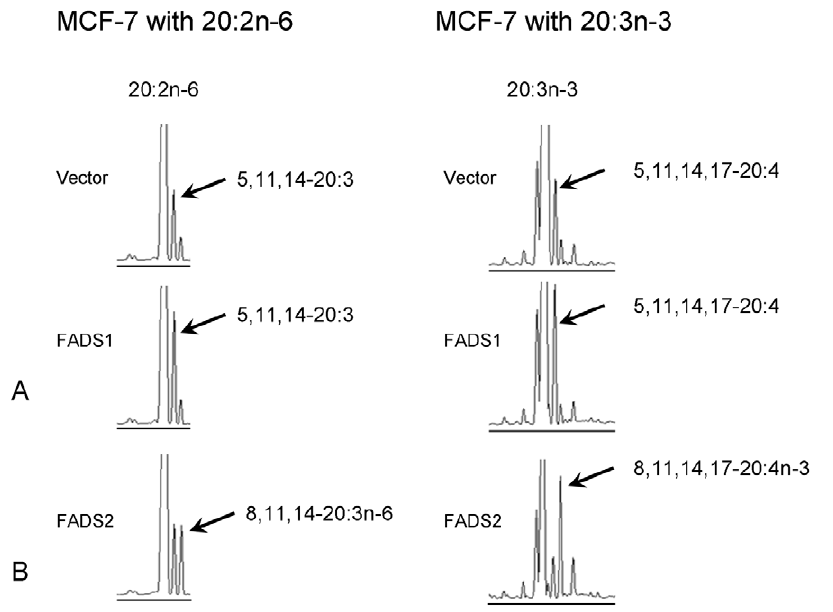
Figure 2. GC results of FADS2 transfected MCF7 cells with 20:2n 2 6 (8,11–20:2) and 20:3n 2 3 (8,11,14–20:3) fatty acids. A: FADS1- transfected cells D 5-desaturate 20:2n 2 6 R 5,11,14–20:3 and 20:3n 2 3 R 5,11,14,17–20:4. B: FADS2 transfected cells D 8-desaturate 20:2n 2 6 R 20:3n 2 6 and 20:3n 2 3 R 20:4n 2 3.